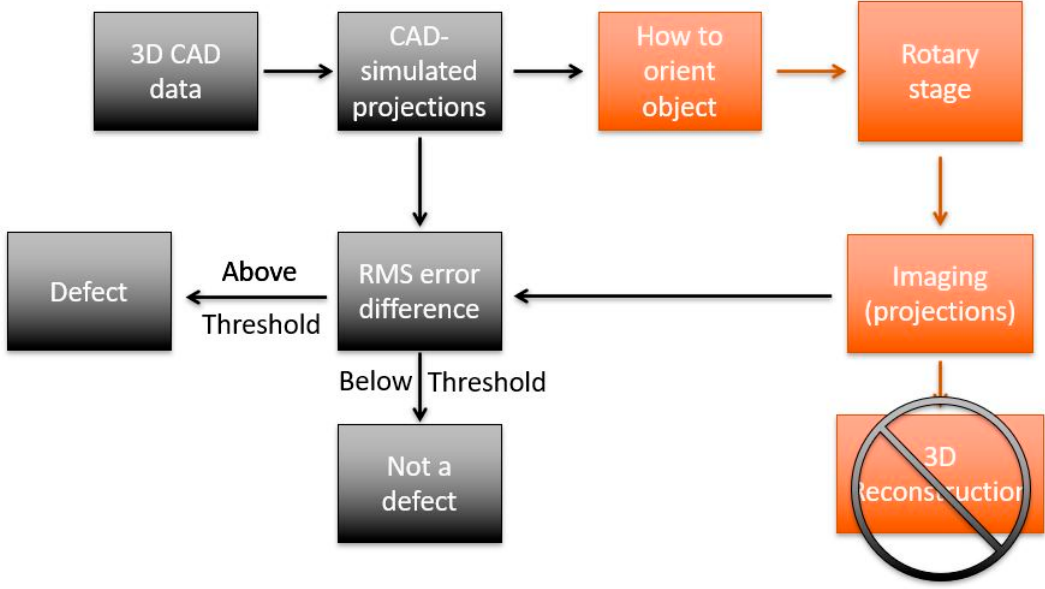
Figure 3. Partial architecture based on “CAD-based defect inspection with optimal view angle selection based on polychromatic X-ray projection images” by Presenti et al. [4].